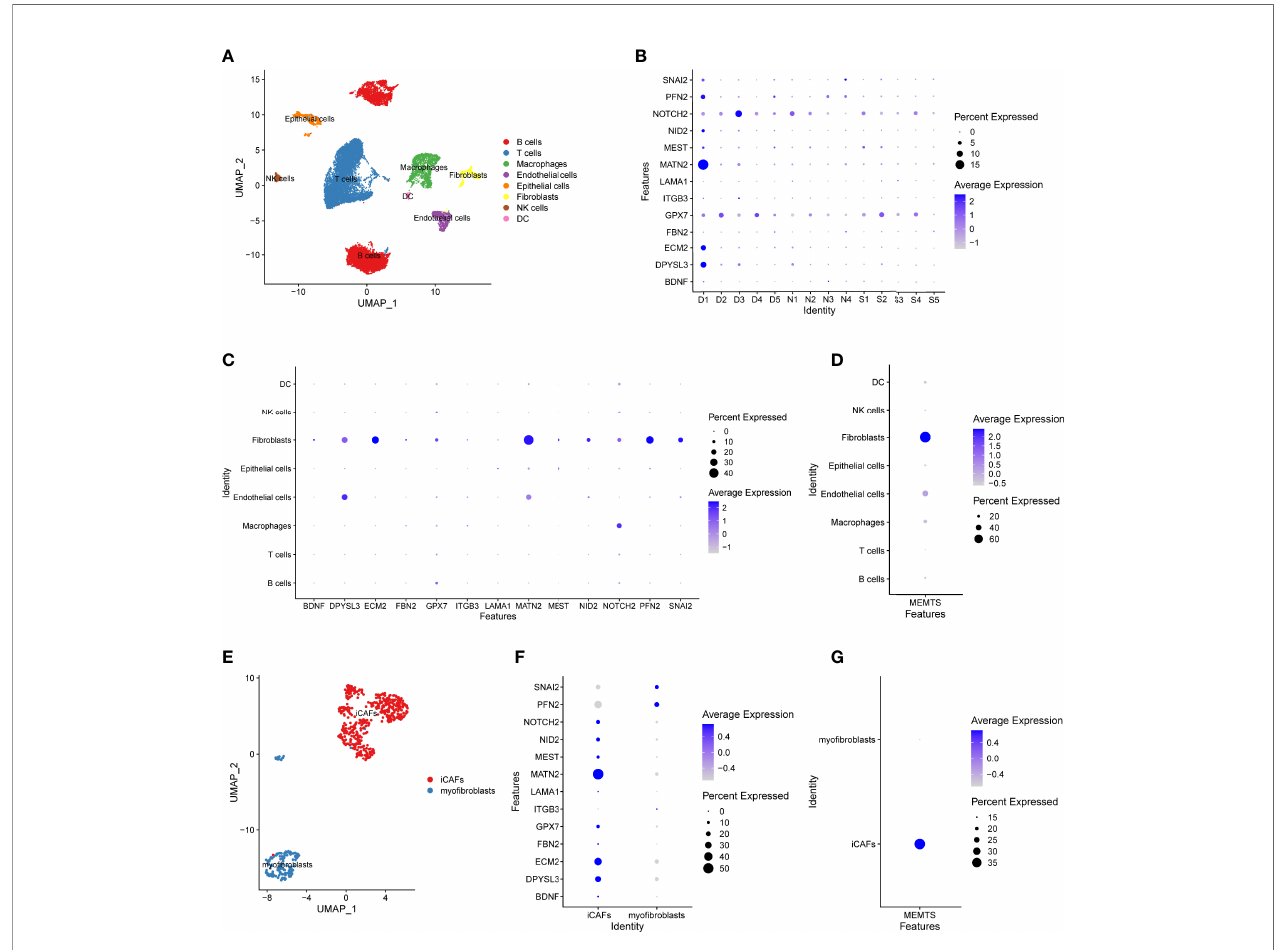
FIGURE 7 | The distribution of the MEMTS in tumor microenvironment. (A) UMAP plot showed eight cell types from 19,765 cells. (B) The different features of hub genes in deep layer (D1, D2, D3, D4, D5) and super fi cial layer (S1, S2, S3, S4, S5) of tumor tissues and paired normal tissues (N1, N2, N3, N4). (C) The different expression of hub genes in eight cell clusters. (D) MEMTS was mainly concentrated in the fi broblasts. (E) Fibroblasts were classi fi ed into in fl ammatory CAFs and myo fi broblasts on the basis of different molecular characteristics. (F) The different features of hub genes in in fl ammatory CAFs and myo fi broblasts. (G) MEMTS was primarily manifested in in fl ammatory